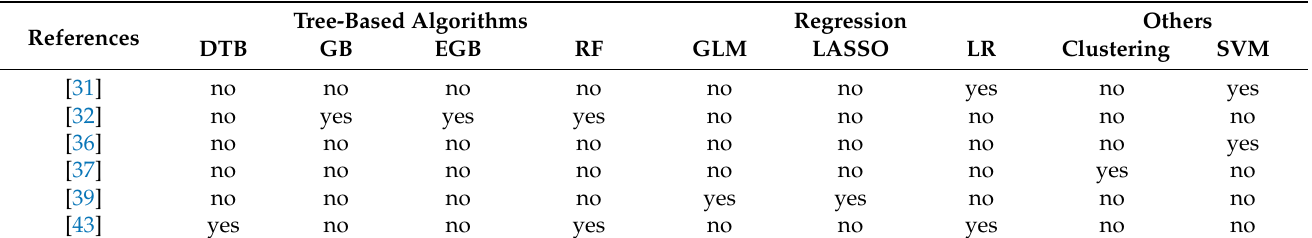
Table 5. List of papers that make use of any machine learning methodology that is not of the neural networks category. DTB: Decision tree bagging, GB: Gradient boosting, EGB: Extreme gradient boosting, RF: Random forest, GLM: Generalized linear model, LASSO: Least absolute shrinkage and selection operator regression, LR: Logistic regression, SVM: Support vector